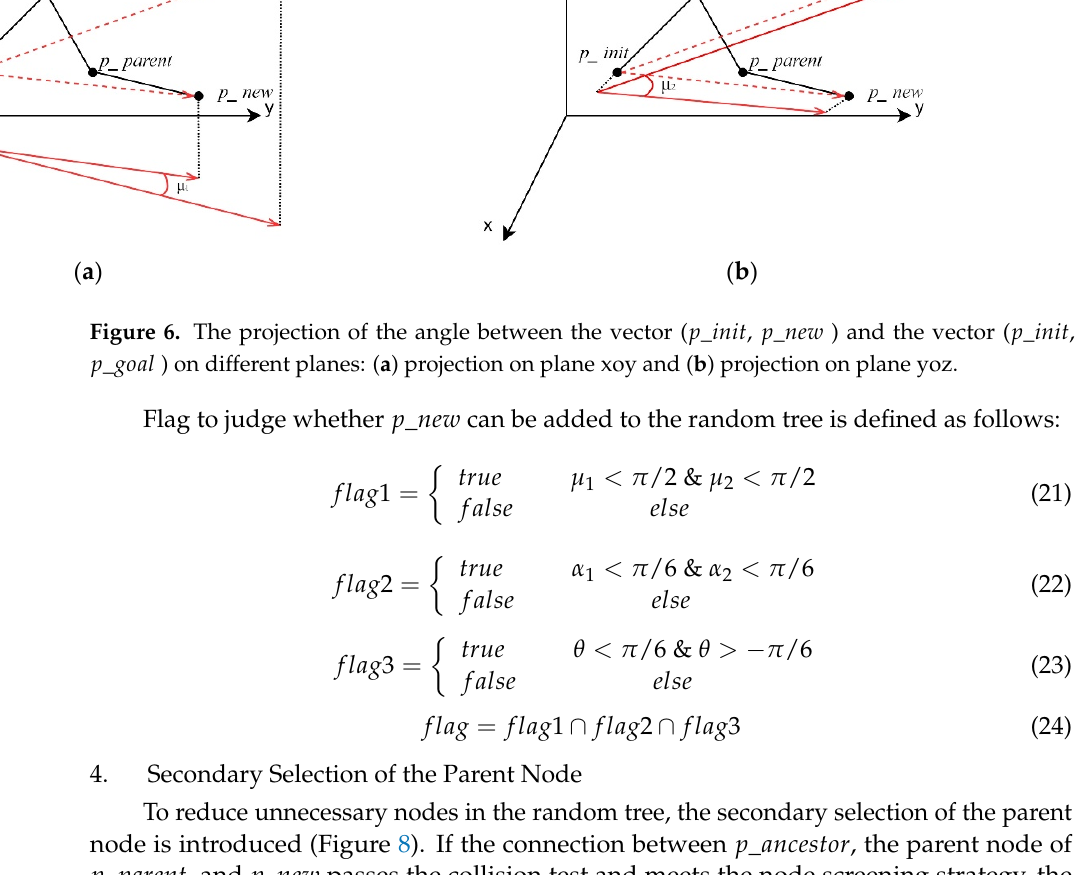
( d ) Figure 7. The pitch angle and projection of the angle between the vector ( _ p parent , _ p new ) and the vector ( _ p ancestor , _ p parent ) on different planes: ( a ) projection on plane xoz; ( b ) pro- jection on plane yoz; ( c ) projection on plane xoy; and ( d ) pitch angle.